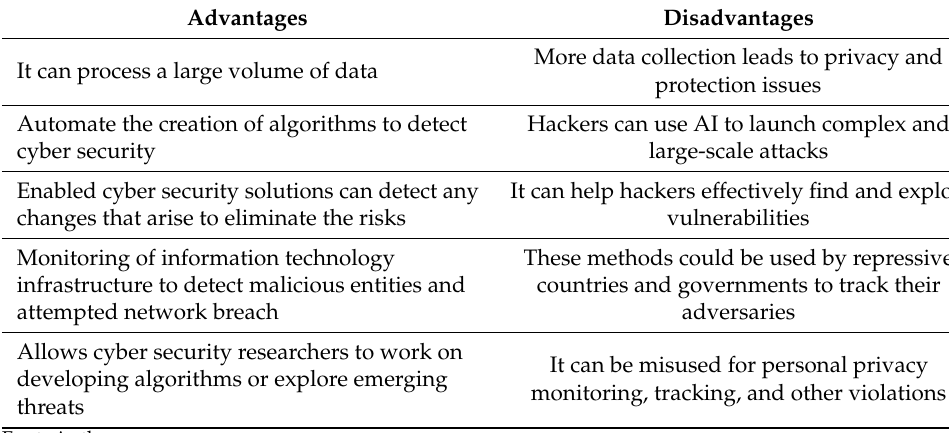
Table 4. Advantages and Disadvantages of AI for cyber